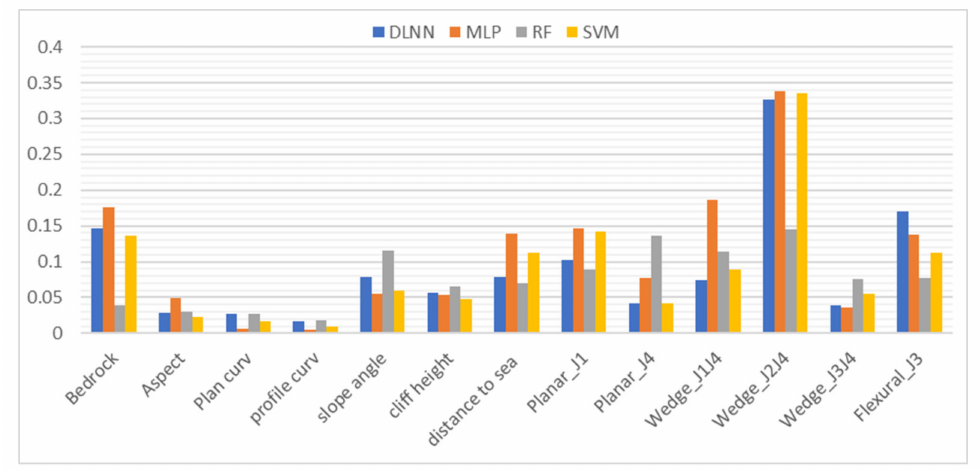
Figure 9. The results of variable importance, showing the importance of each of the influencing factors in landslide